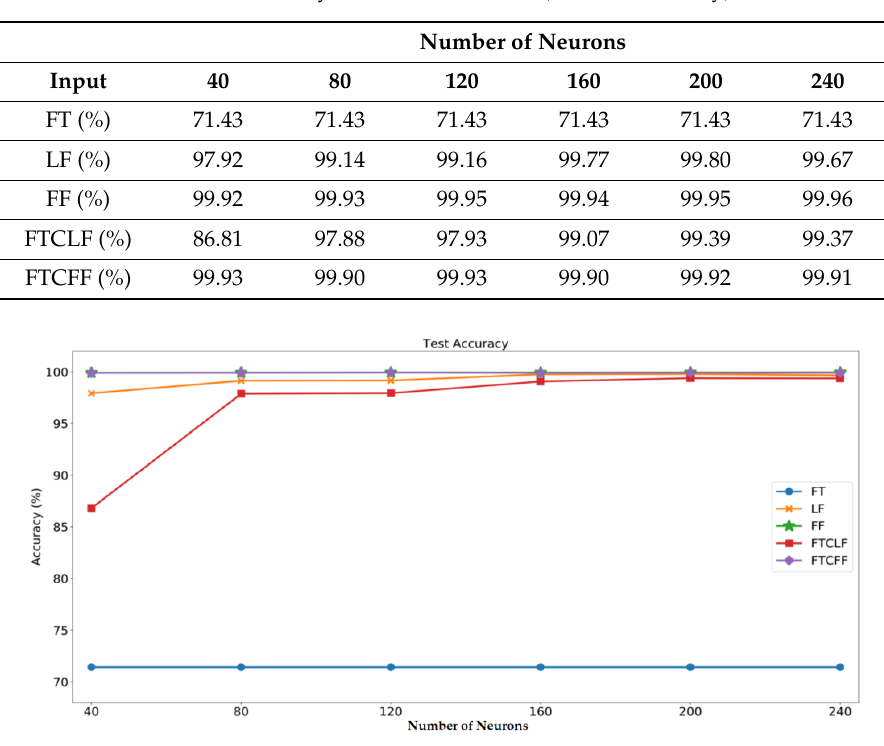
Table 6. Comparison table for training time.